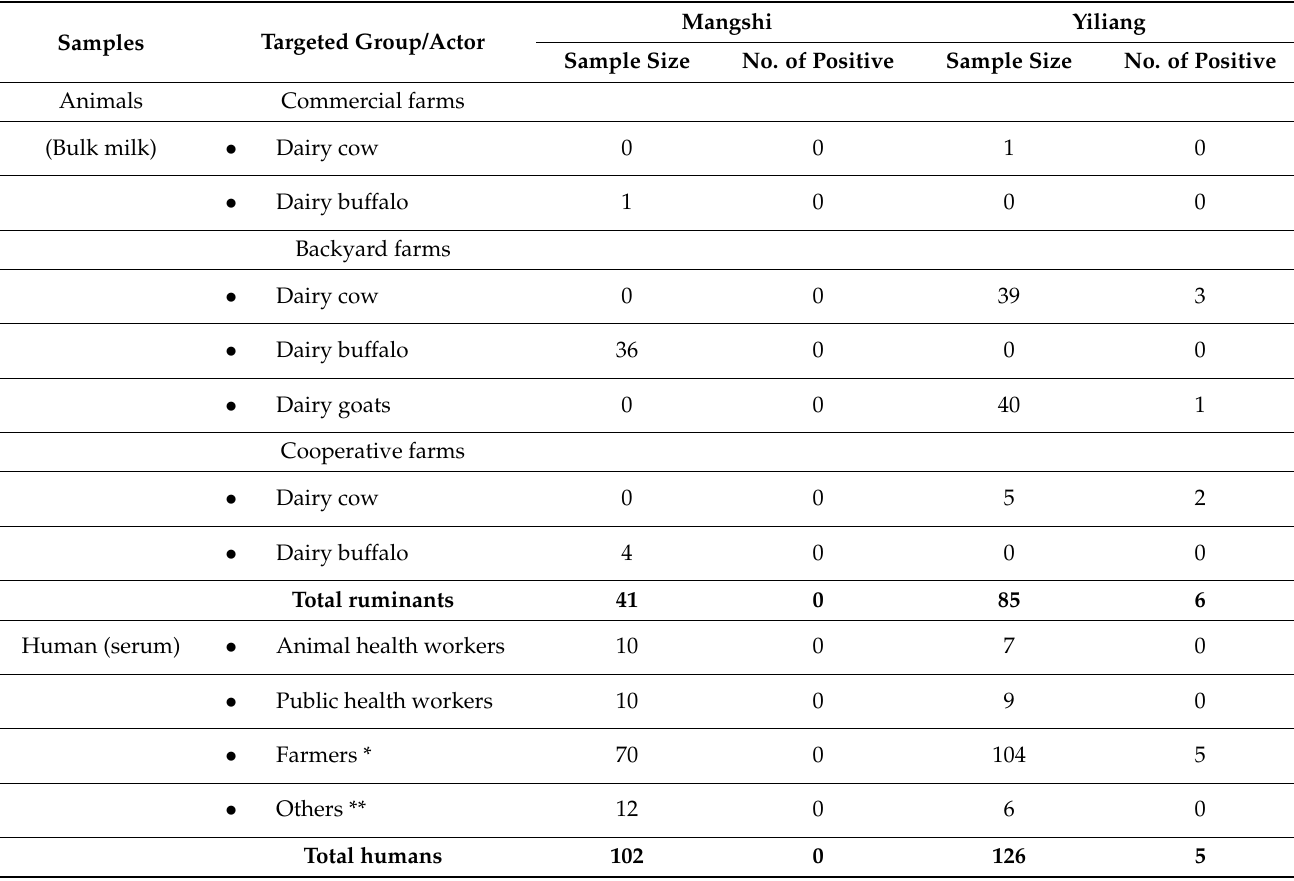
Table 4. Milk and serum samples tested for Brucella antibodies in Yunnan Province, China.